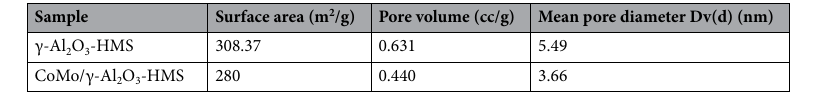
Table 1. Textural properties of the support and of the catalyst.